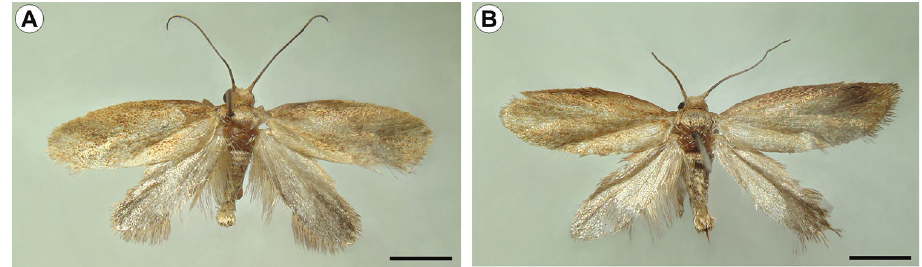
Figure 2. Pinned-dried C. pampeanus adults, dorsal view: A male (holotype, LMCI 188-4) B female paratype (LMCI 188-6). Scale bars: 2